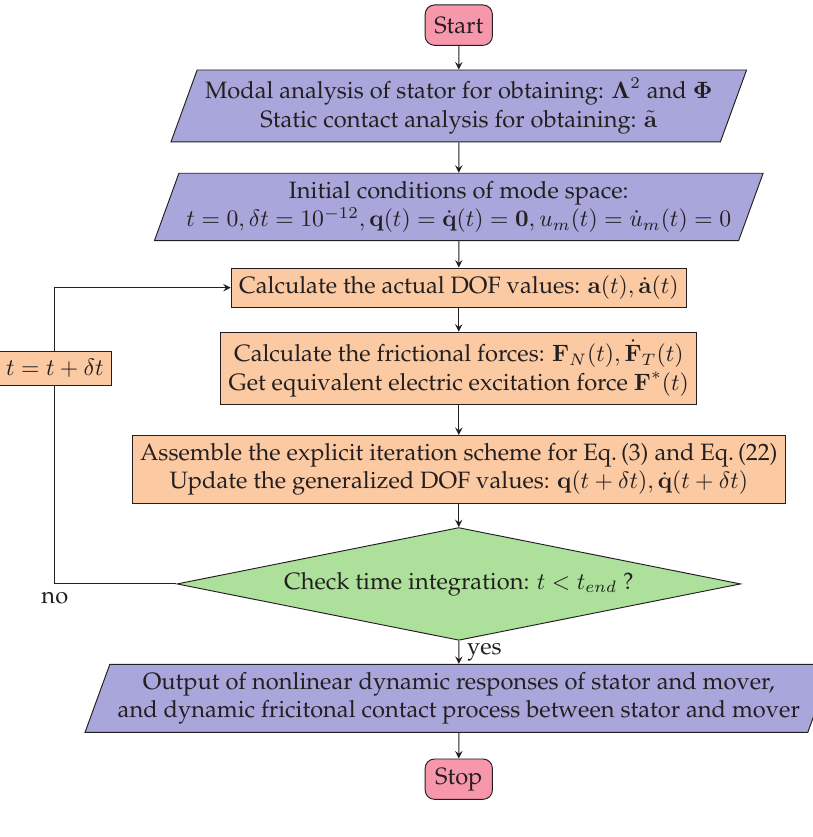
Figure 6. Flowchart of the dynamic contact